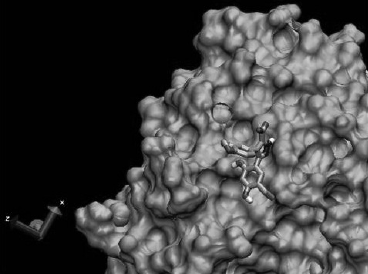
Figure 2. Stereo view of the average MD structure of the simulated Hsp90 and its inhibitor (4BC); the stick models represent inhibitor. The protein active site region is shown as a